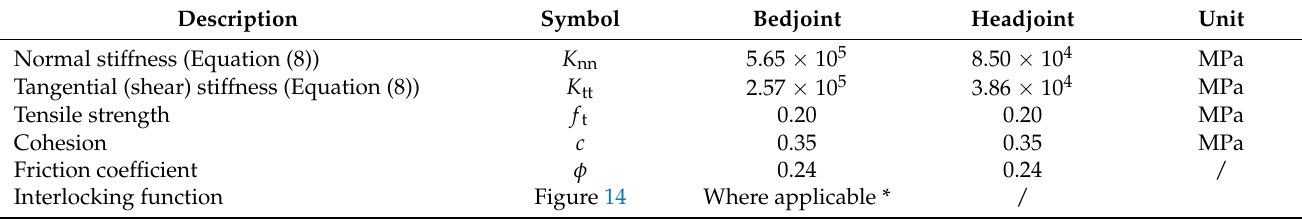
Figure 14. Multi-linear interface functions (initial values). ( a ) Cohesion softening/hardening function; ( b ) tensile softening function. Table 3. Initial interface material properties.